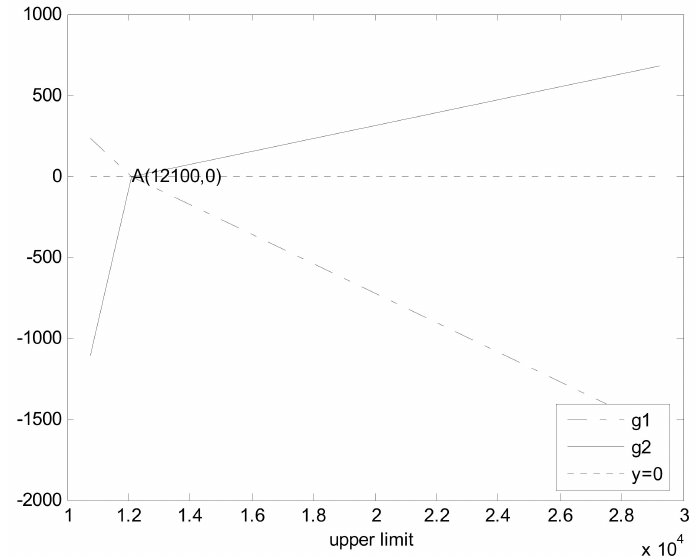
Figure 1. Patterns of changes in the first order conditions of the two objective functions and optimal upper